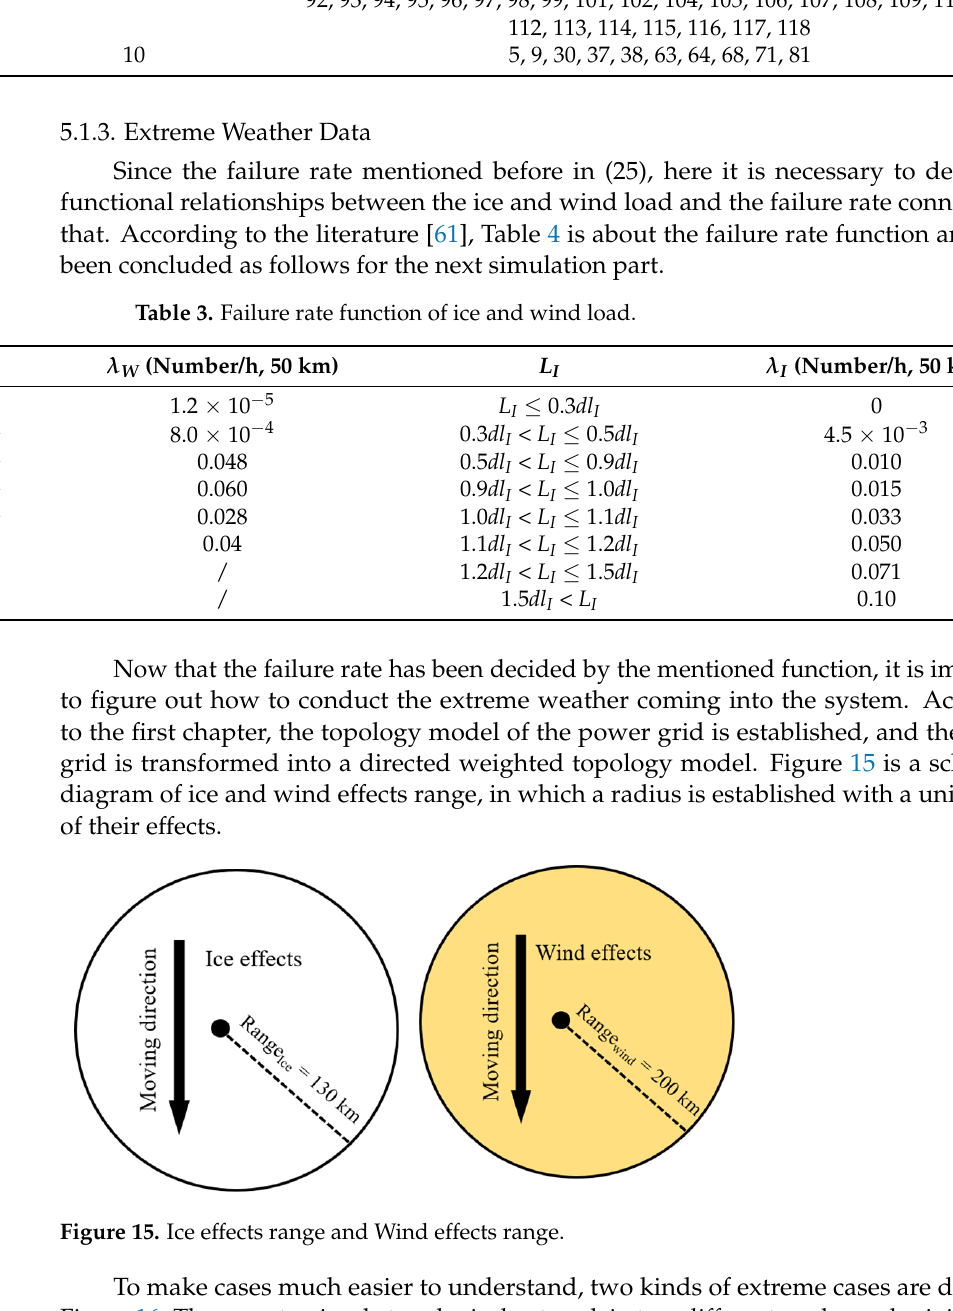
Table 3. Failure rate function of ice and wind load.